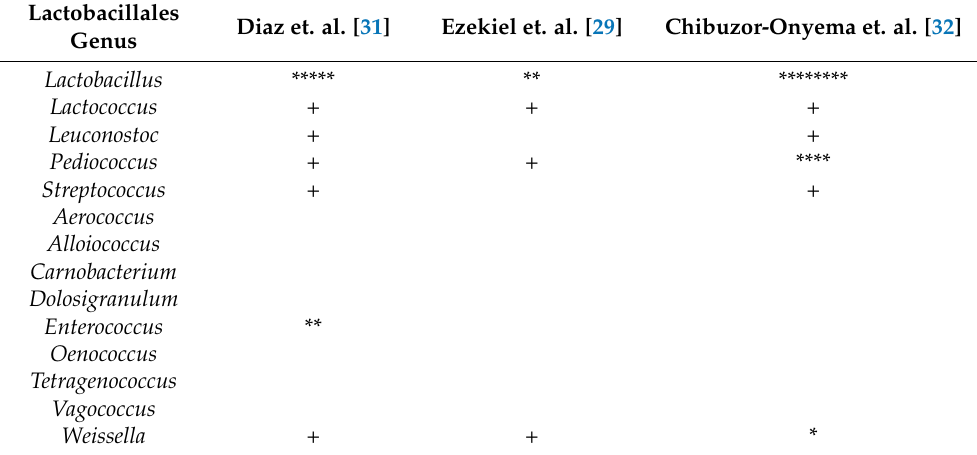
Table 1. Genera of LAB that were detected in millet fermentation microbiomes. The asterisks indicate the most abundant genera with each asterisk representing one sample. A plus symbol indicates the presence of a genus in at least one